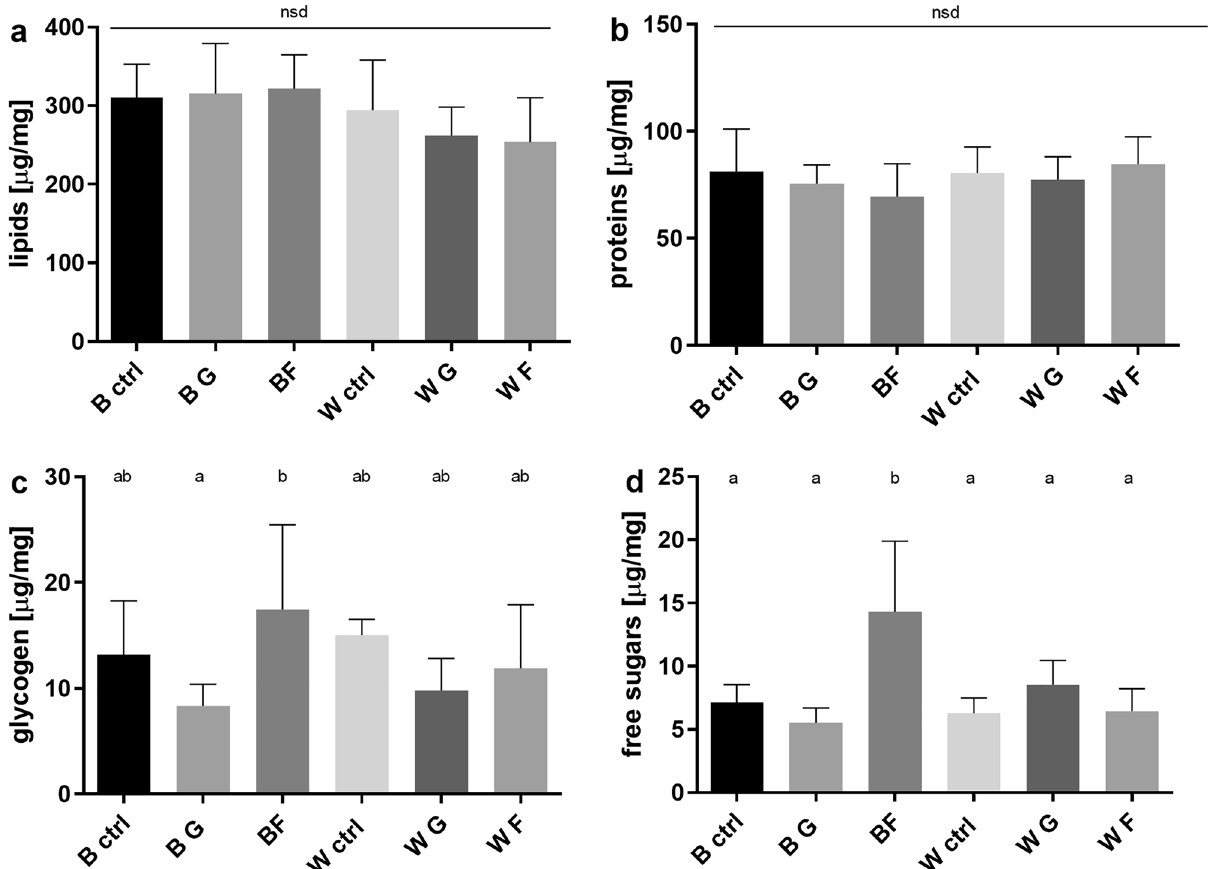
Figure 5. Average concentration (mean ± SD, n = 6) of four major groups of biomolecules in the body of 30-day- old larvae ( a ) lipids (ANOVA F (5, 30) = 1.832,P = 0.1367); ( b ) proteins (ANOVA F (5, 30) = 0.8768,P = 0.5084); ( c ) glycogen (ANOVA F (5, 30) = 2.868, P = 0.0312); ( d ) free sugars (ANOVA F (5, 30) = 8.868, P < 0.0001). B black eyed strain, W white-eyed strain, CTRL control group, F fructose, G glucose. Different letters denote groups differing significantly; Tukey’s multiple comparisons test, P <